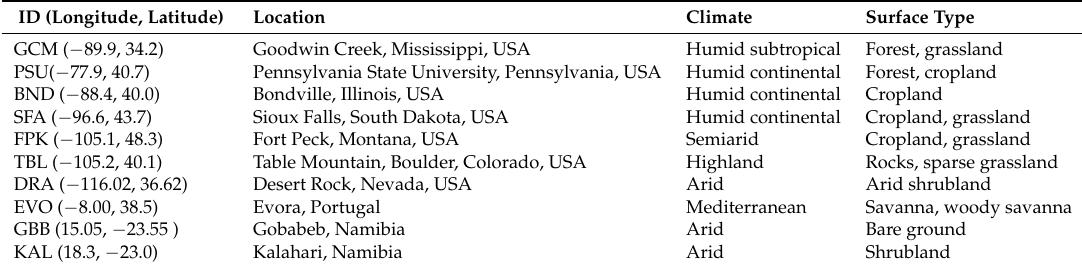
Table 1. Characteristics of the in situ stations measuring the